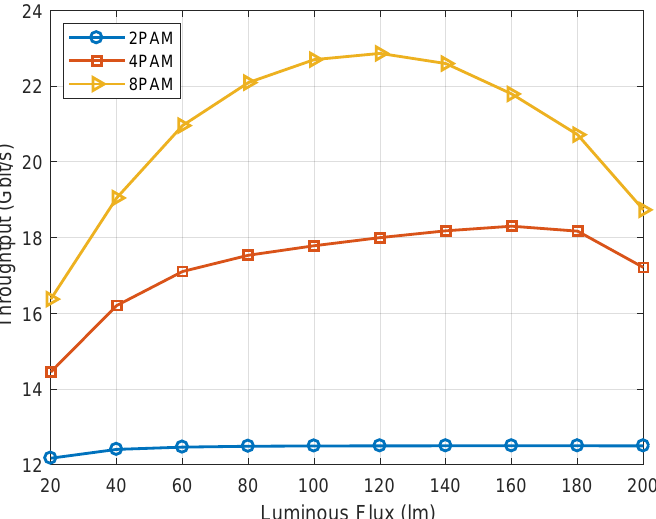
Figure 5. The throughput performance of the proposed precoder for different modulation orders. PAM, pulse amplitude modulation.